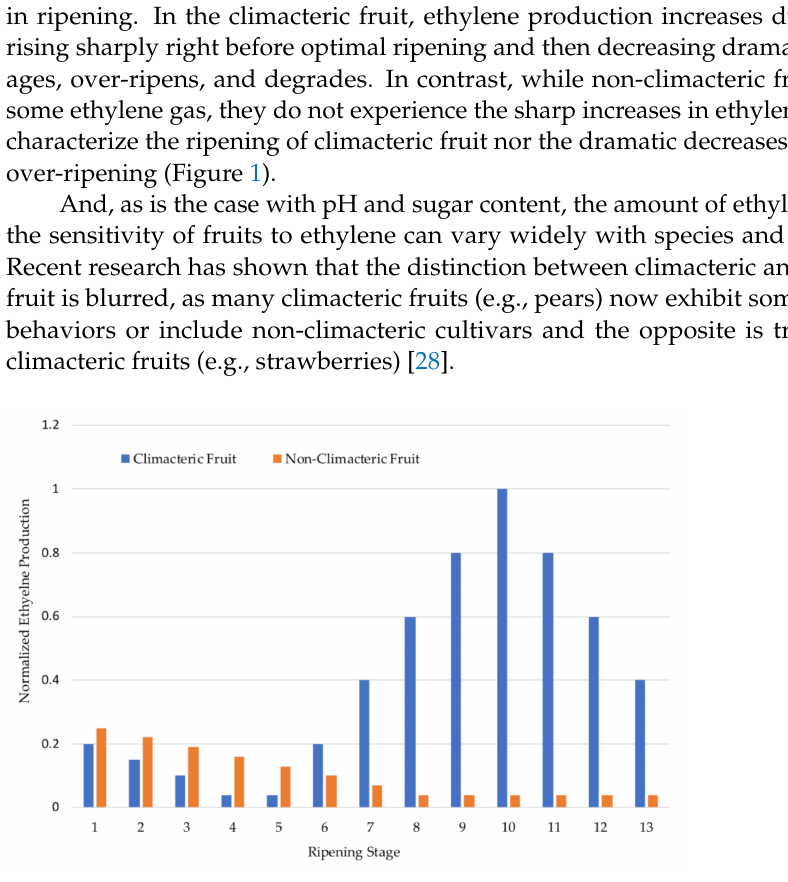
Figure 1. Ethylene Production in Climacteric and Non-Climacteric Fruits. Adapted from